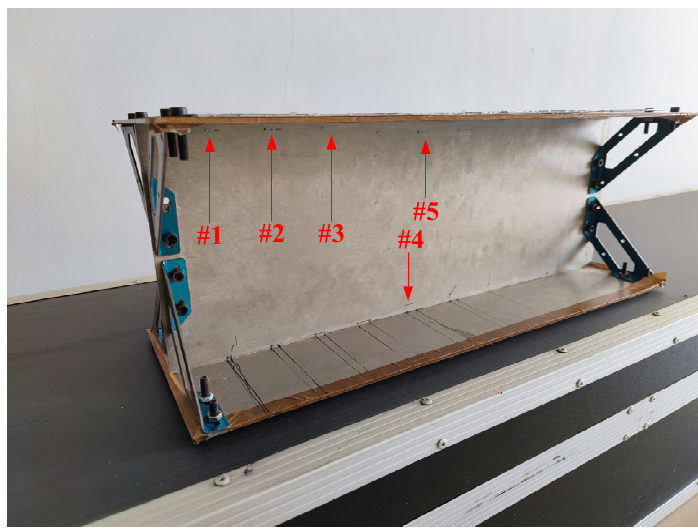
Figure 19. Physical drawing of PRFECT system for aircraft long truss structure.